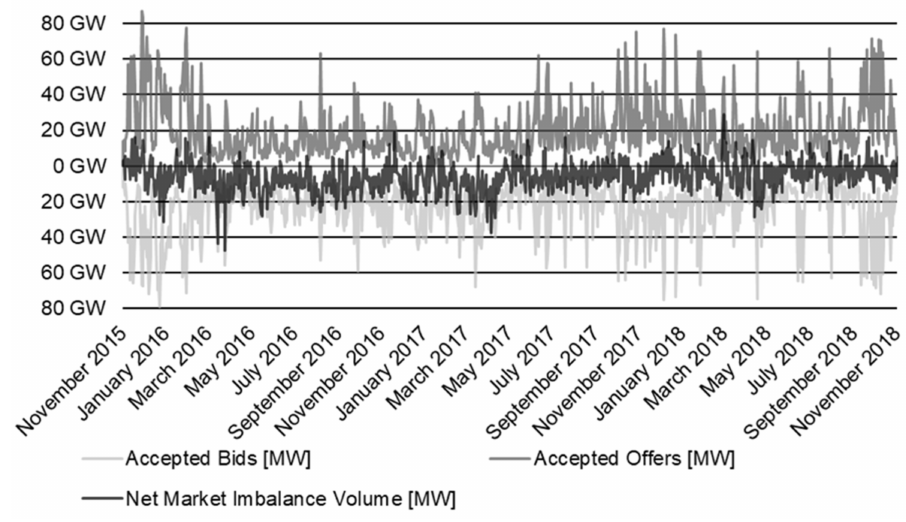
Figure 2. Daily volumes traded on the BM (i.e., accepted bids and offers) in PAR50 period [54] and net market imbalance volume [86].